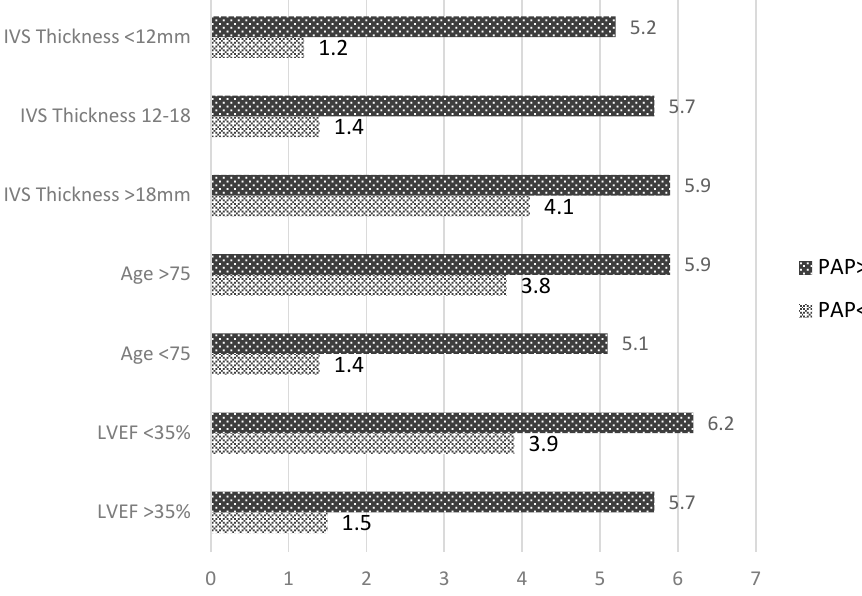
Figure 4. Early postoperative risk of death in patients with aortic stenosis depending on the mean PAP. The predictive value for death at 2 years postoperatively of left ventricular systolic dysfunction, age > 75 years, or interventricular septum thickness was the same in patients with PHT > 50 mmHg and higher in patients with normal PAP. In these patients, left ventricular ejection fraction < 35%, age > 75 years, or interventricular septum thickness >18 mm increased by 4-fold the risk of death at 2 years postoperatively. The presence of PHT > 50 mmHg homogenized the relative early postoperative risk of death. It was increased regardless the left ventricular systolic performance, patients’ age, or the presence of the left ventricular hypertrophy.